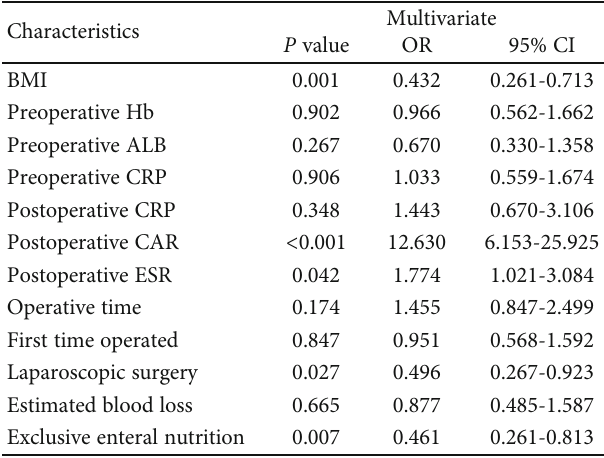
Table 2: Multivariate analysis of factors associated with postoperative complications.